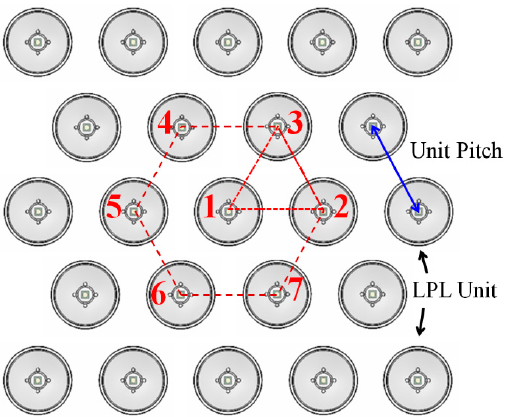
Figure 4. Schematic of a simple LPL-EM consisting of 23 LPL units arranged in a hexagonal shape.